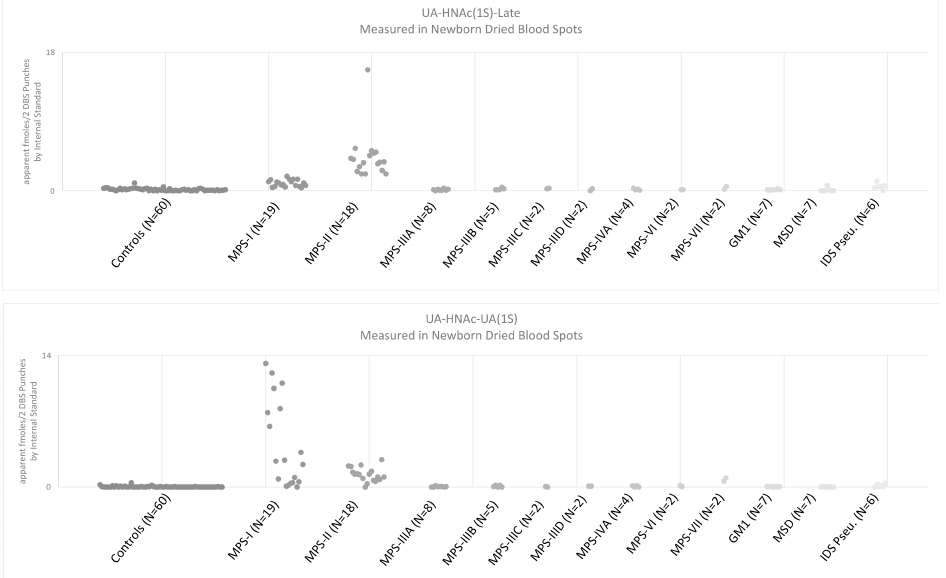
Figure 8. Levels of each MPS-II endogenous biomarker are compared between newborn DBS from 60 random healthy controls, 19 newborns with MPS-I, 18 newborns with MPS-II, 8 newborns with MPS-IIIA, 5 newborns with MPS-IIIB, 2 newborns with MPS-IIIC, 2 newborns with MPS-IIID, 4 new- borns with MPS-IVA, 2 newborns with MPS-VII, 7 newborns with GM1 Gangliosidosis, 7 newborns with multiple sulfatase deficiency (MSD), and 6 newborns with IDS